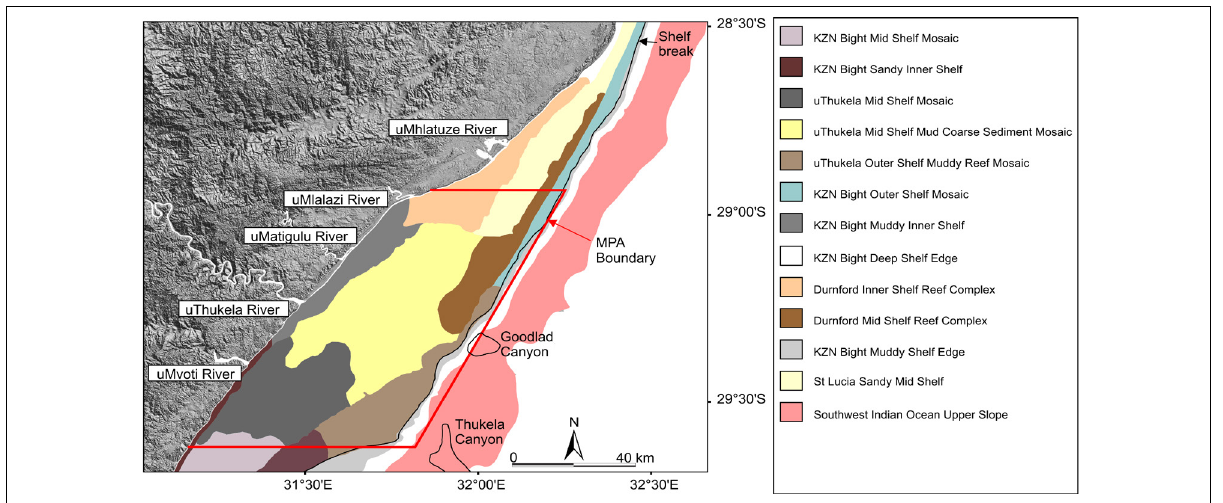
Figure 2: Most recent benthic habitat map for the uThukela Banks Marine Protected Area. 8 Note that the estuaries for each river system are